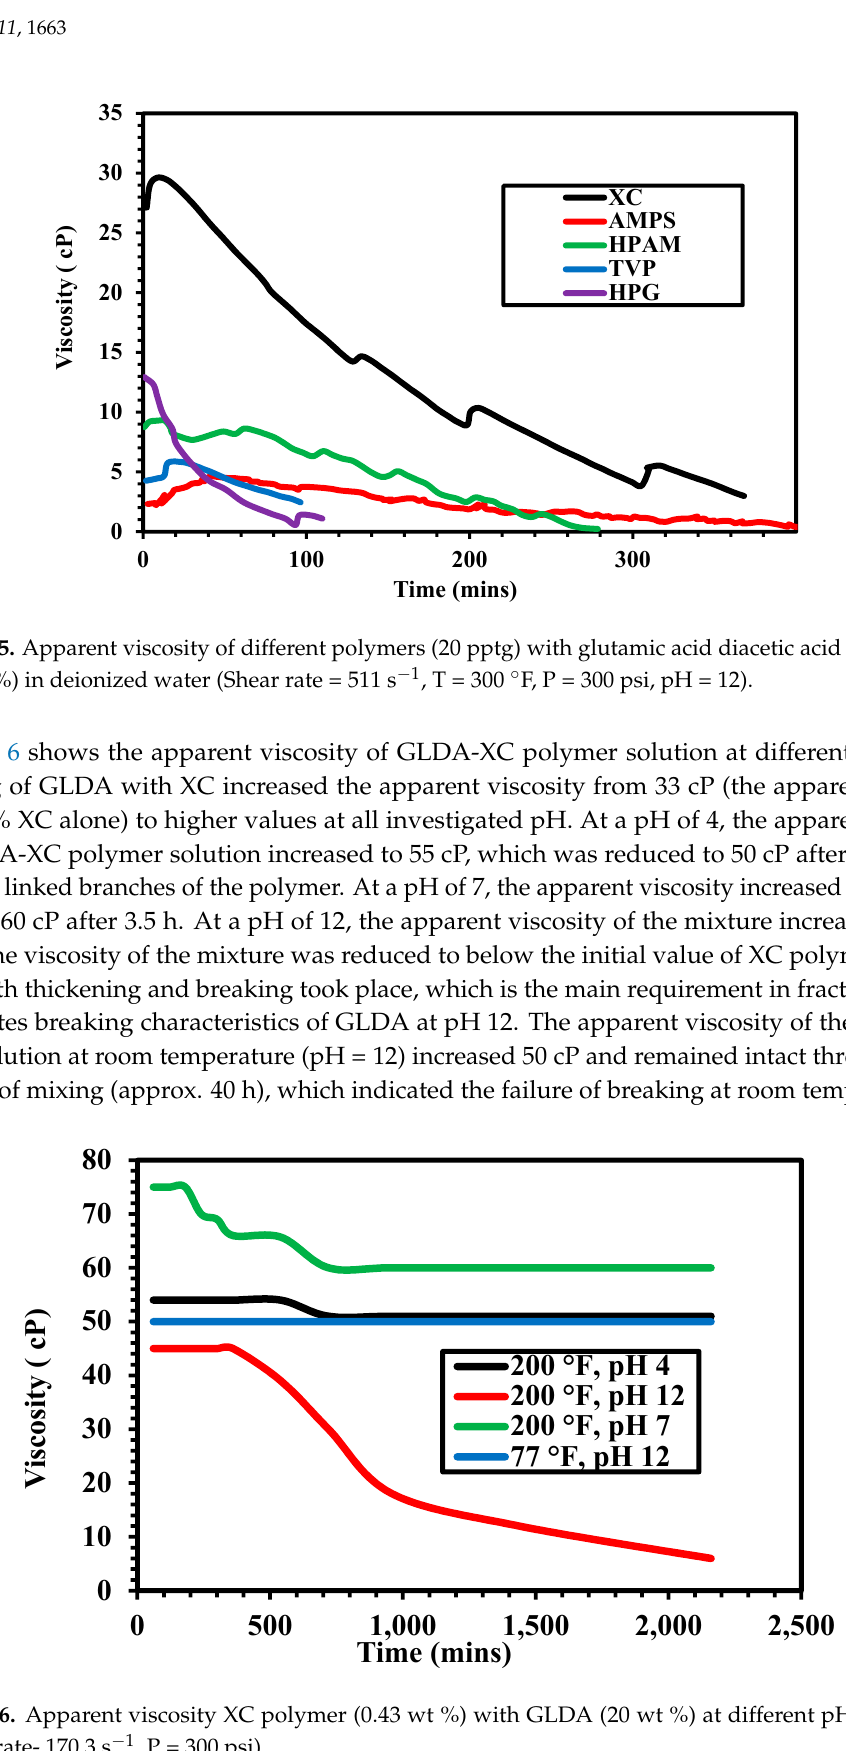
Figure 6. Apparent viscosity XC polymer (0.43 wt %) with GLDA (20 wt %) at different pH values (Shear rate- 170.3 s − 1 , P = 300 psi).